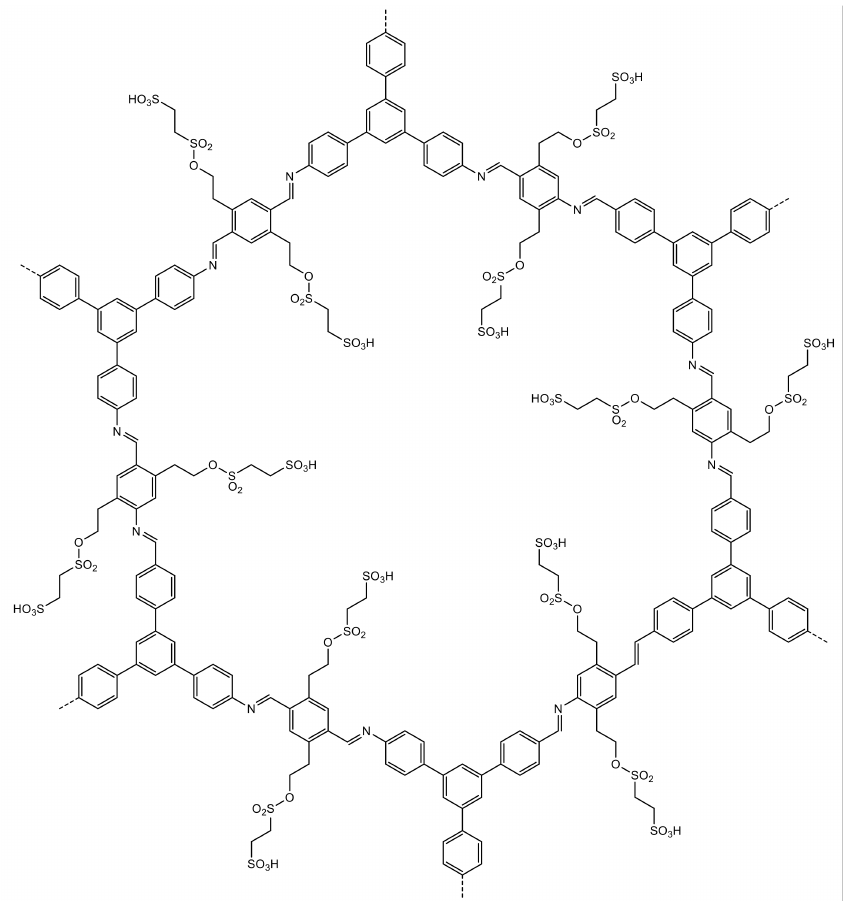
Figure 12. Structure of COF-SO 3